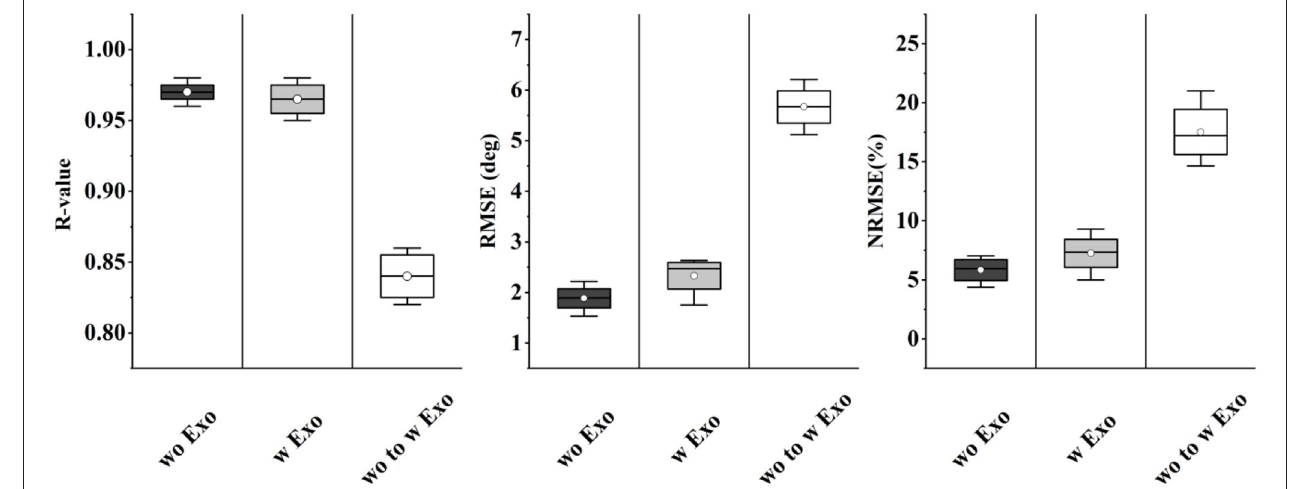
FIGURE 11 | The prediction results involving the exoskeleton.